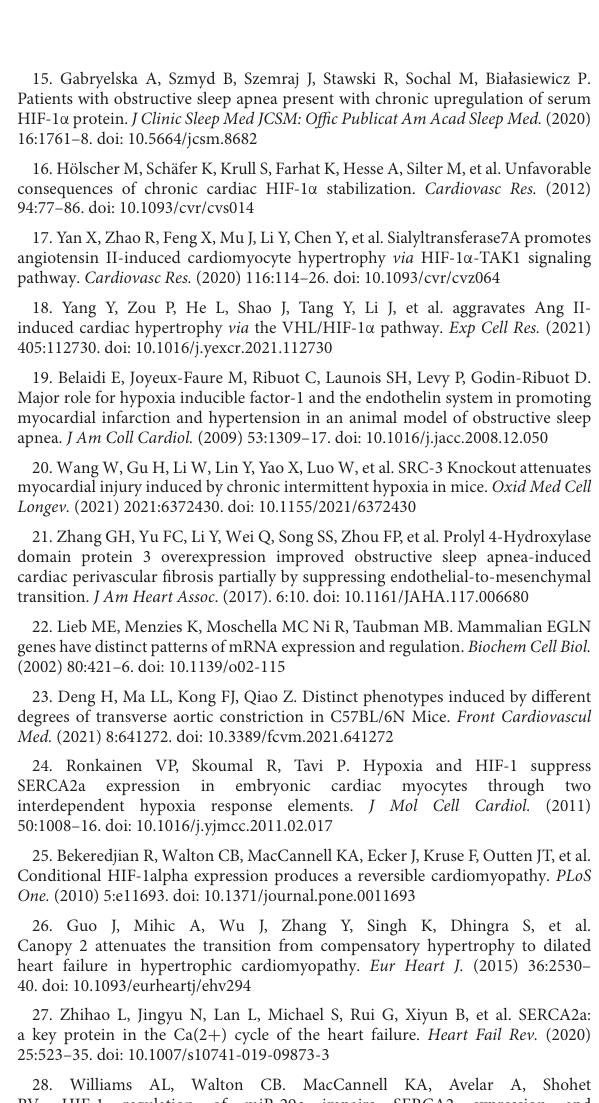
SUPPLEMENTARYFIGURE1 Flow chart of the experimental process. Surgical death: Mice that died during TAC surgery due to vascular rupture or pneumothorax and other